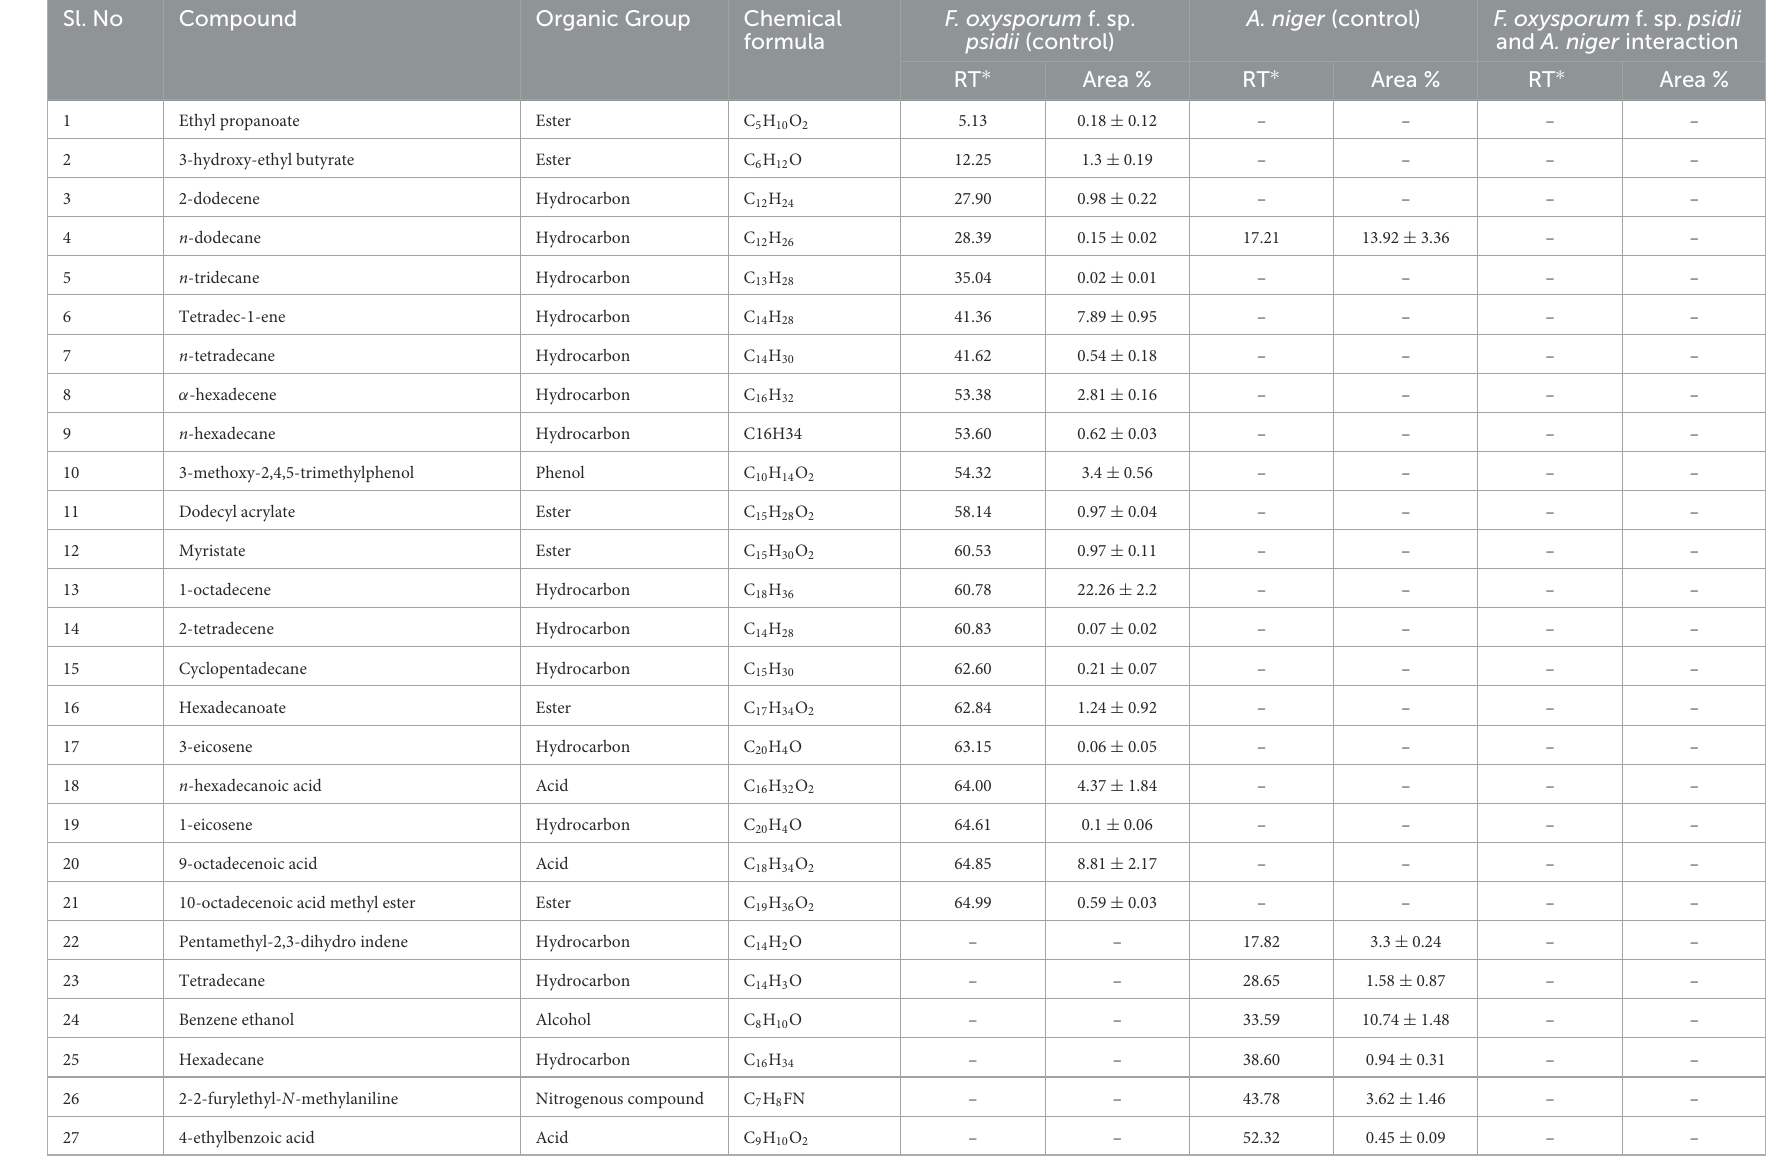
TABLE 5 List of volatile organic compounds (VOCs) in the ethyl acetate fraction during F. oxysporum f. sp. psidii and A. niger interaction, determined by GC–MS. Sl.